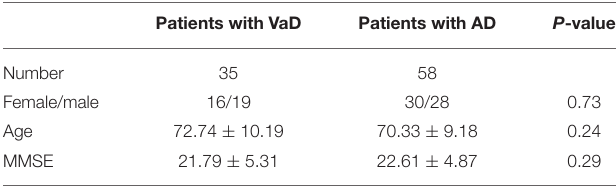
TABLE 1 | Demographic information.